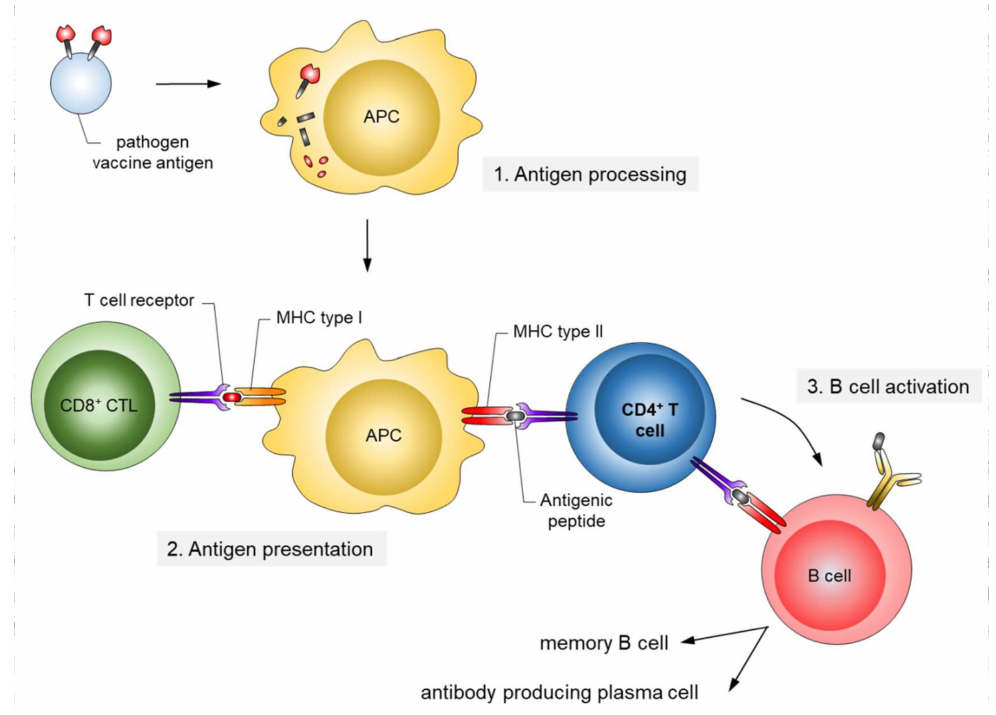
Figure 2. Mechanism of antigen presentation upon infection/active vaccination. Antigens ingested by antigen-presenting cells (APC) are processed by the proteasome, and antigenic peptides are presented on major histocompatibility complexes (MHC) types I and II. The peptide/MHC complexes are recognized by T cells. CD4-positive T helper cells (blue) play a central role in the activation of naïve B cells to differentiate into long-lasting antigen-specific antibody producing